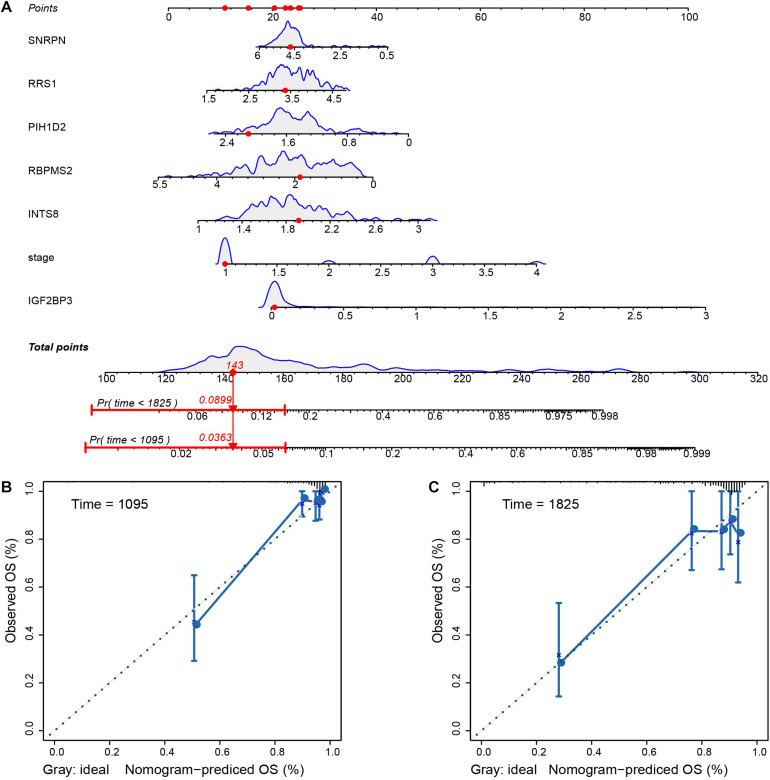
Nomogram for predicting the probability of patient mortality based on six RBPs as well as tumor stage, and calibrations of nomogram in terms of conformity between predicted outcomes and observed outcomes at 3 and 5 years. (A) Nomogram for evaluating the possibility of pRCC patients mortality at 3 and 5 years. Calibration for assessing the conformity between nomogram OS and observed OS at 3 years (B) and 5 years (C).